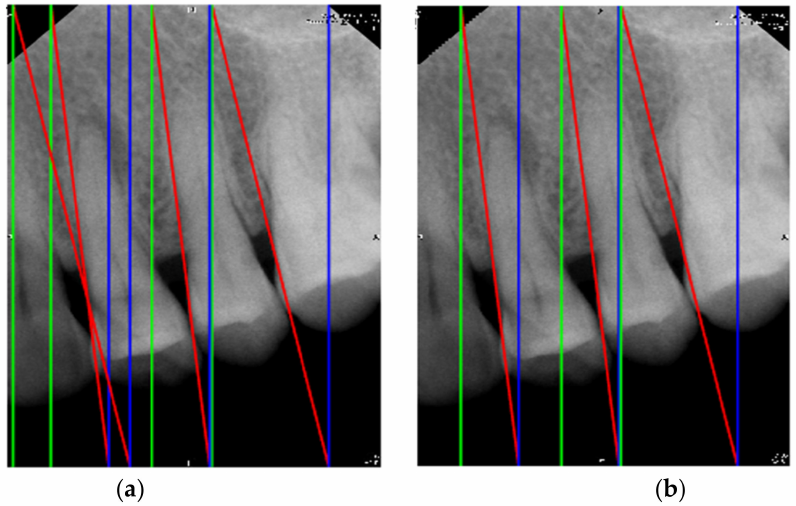
Figure 3. The result of cutting lines. ( a ) all cutting lines, ( b ) removed unnecessary cutting lines.